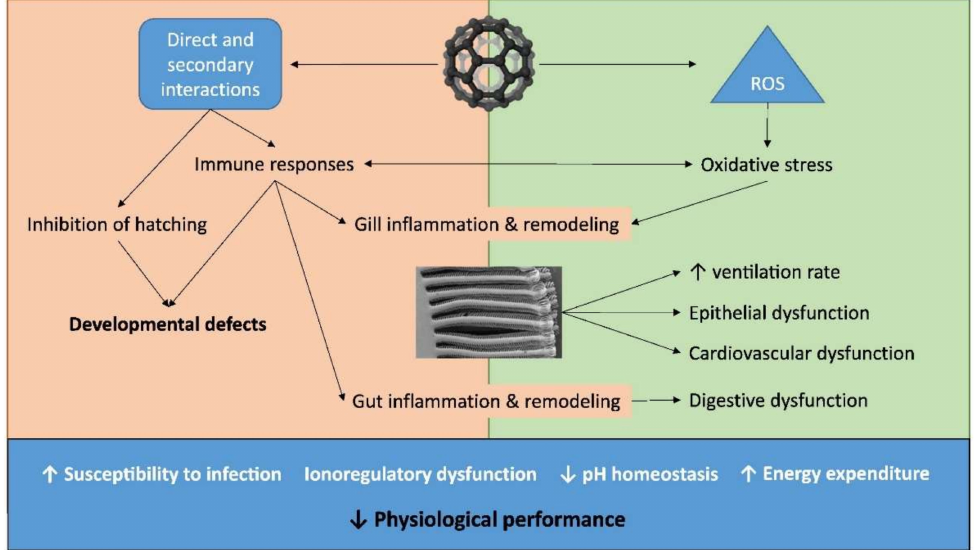
Figure 3. ENMs toxicity routes in an aquatic environment. Image used with the permission of Elsevier